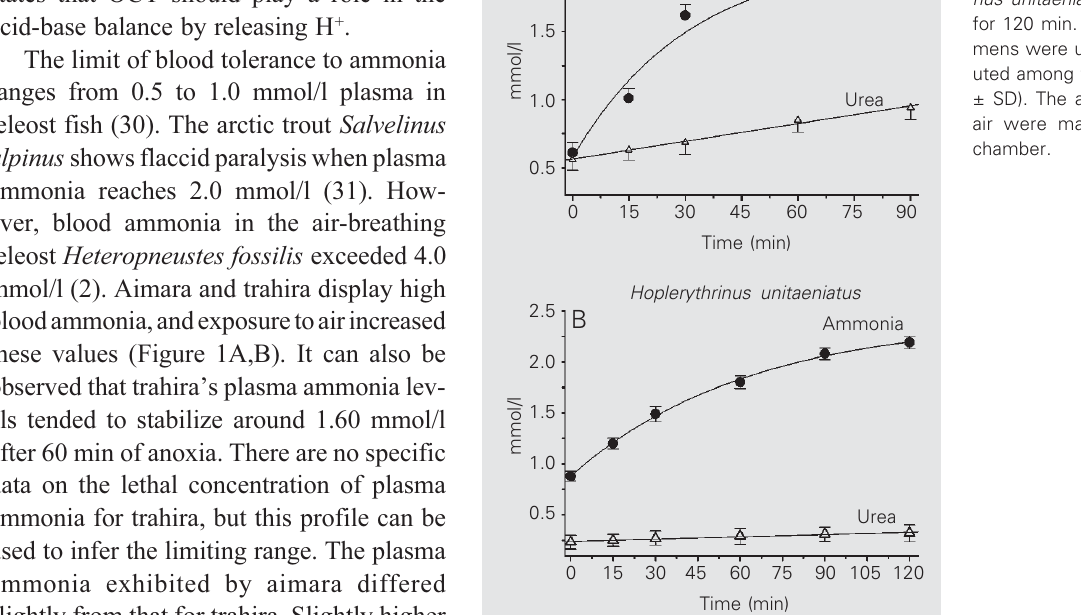
Figure 1. Plasma concentration of ammonia and urea in: A , Hoplias malabaricus exposed to air for 90 min and B , Hoplerythri- nus unitaeniatus exposed to air for 120 min. Twenty-four speci- mens were used equally distrib- uted among four aquaria (N = 6 ± SD). The animals exposed to air were maintained in a wet